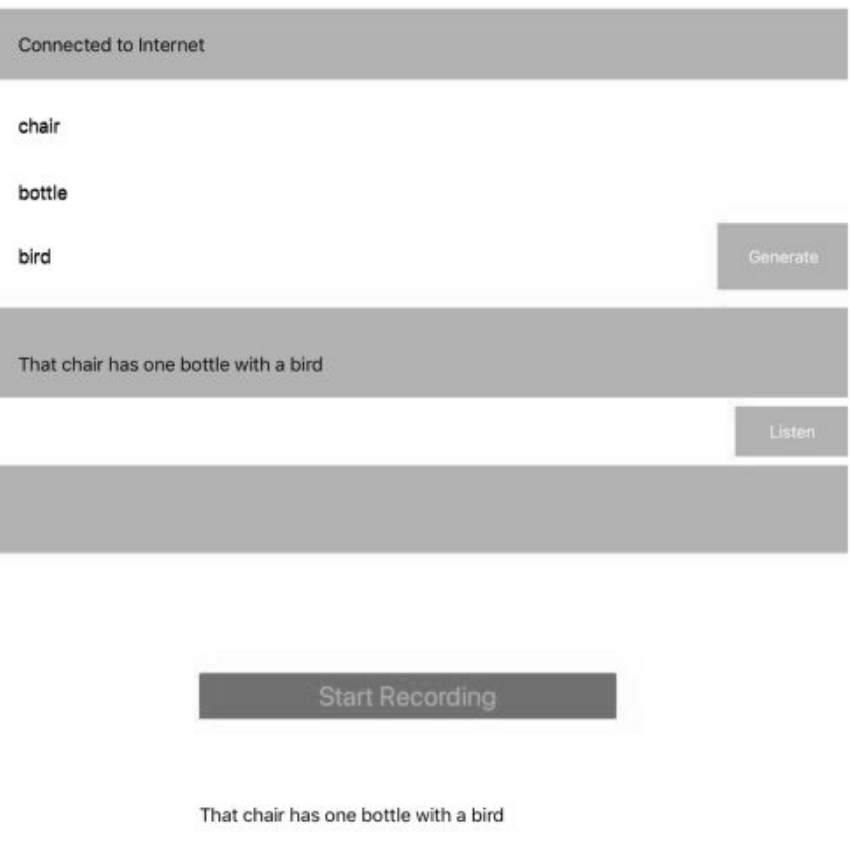
Figure 6. User Interface extraction of 3 words for selecting the closest